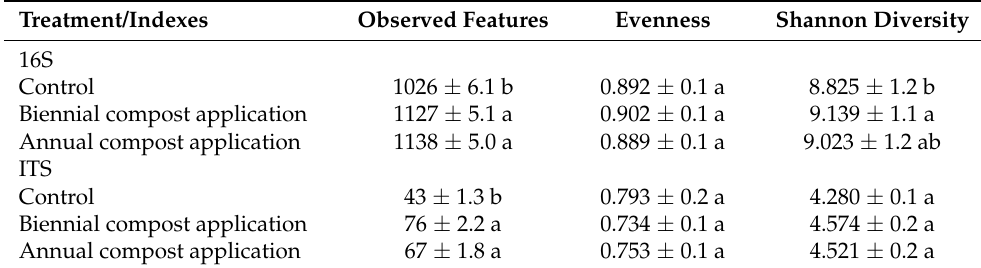
Table 3. Microbial alpha-diversity as affected by frequency of application of municipal solid waste